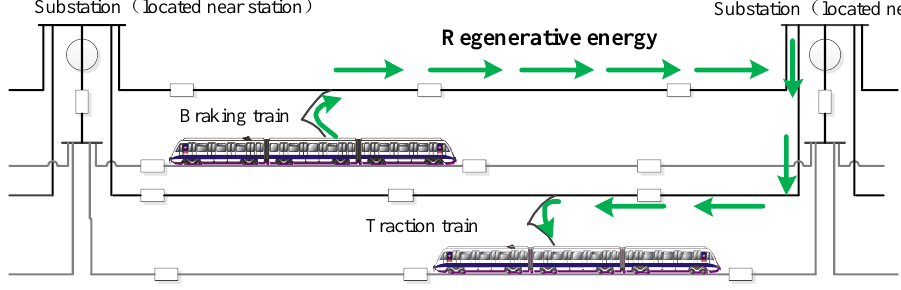
Figure 10. Immediate energy exchange between trains by regenerative braking.